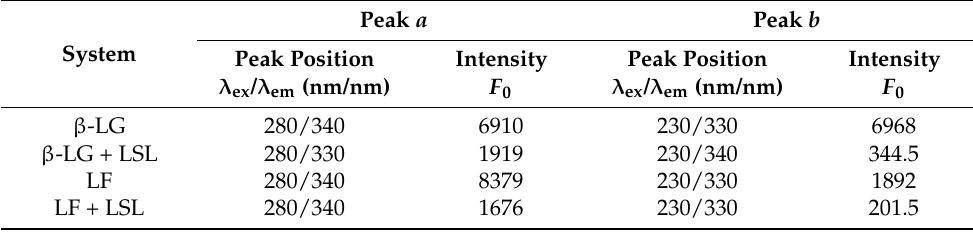
Table 2. Three-dimensional fluorescence spectral parameters of β -LG/LF and LSL. Peak a Peak System